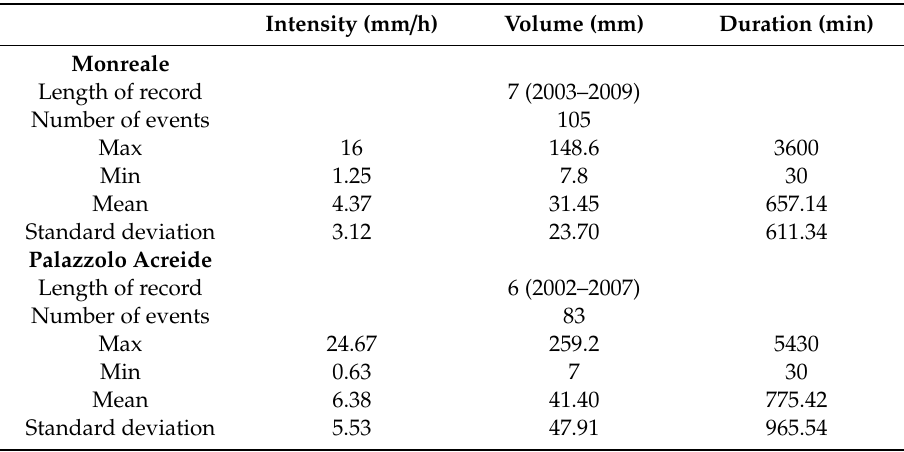
Table 1. Rainfall dataset and statistics of the selected rainfall